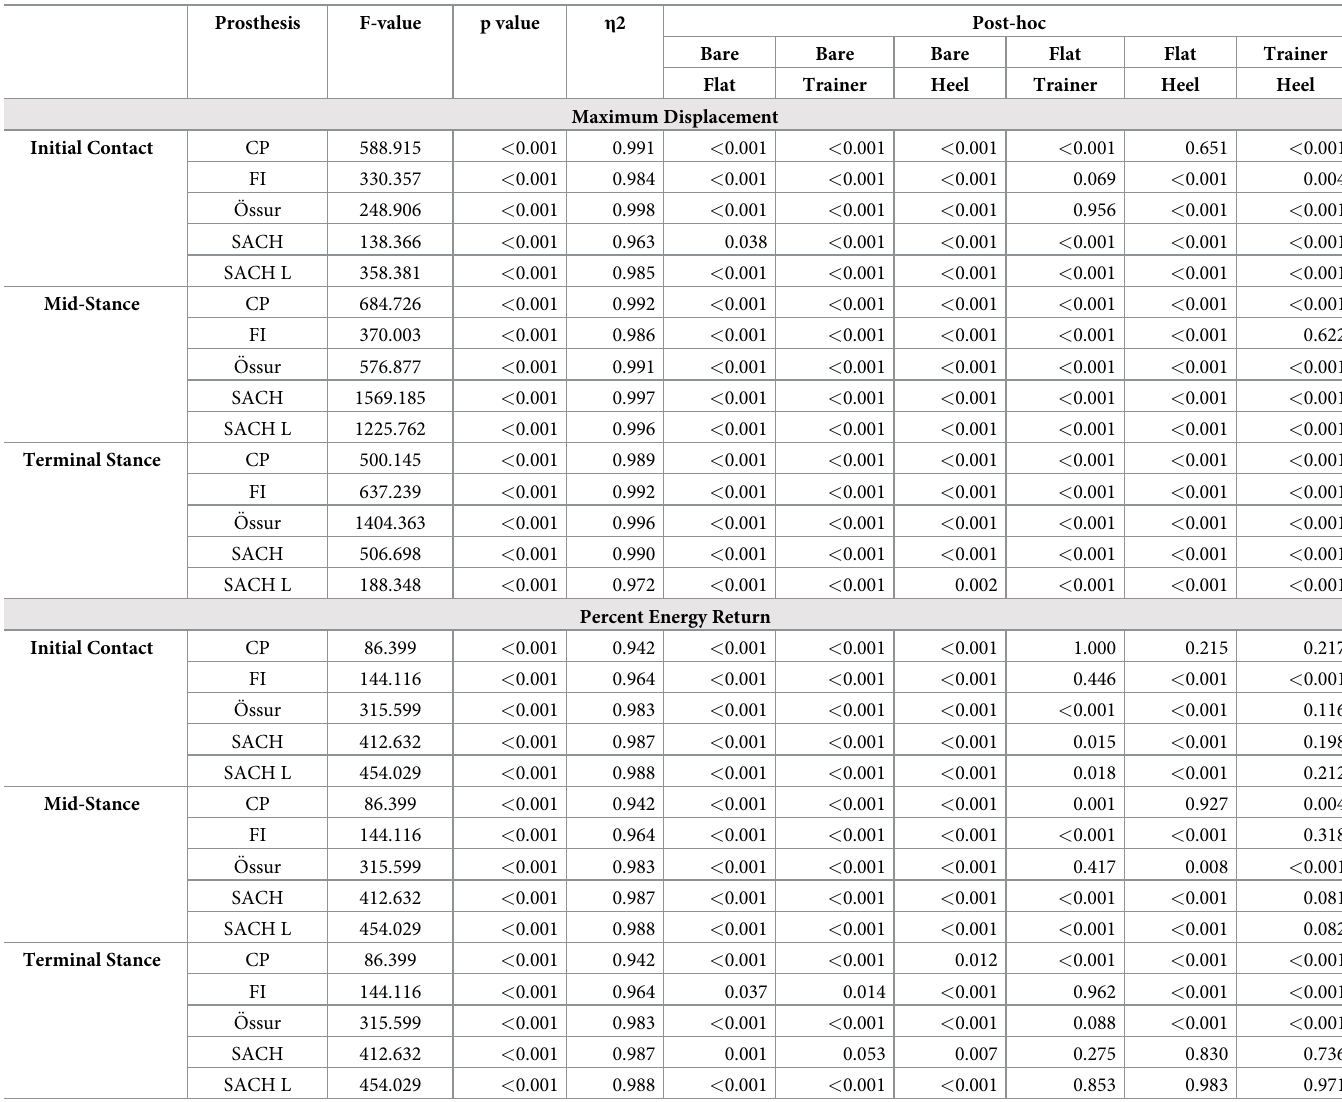
Table 4. Statistical results to assess main effect of